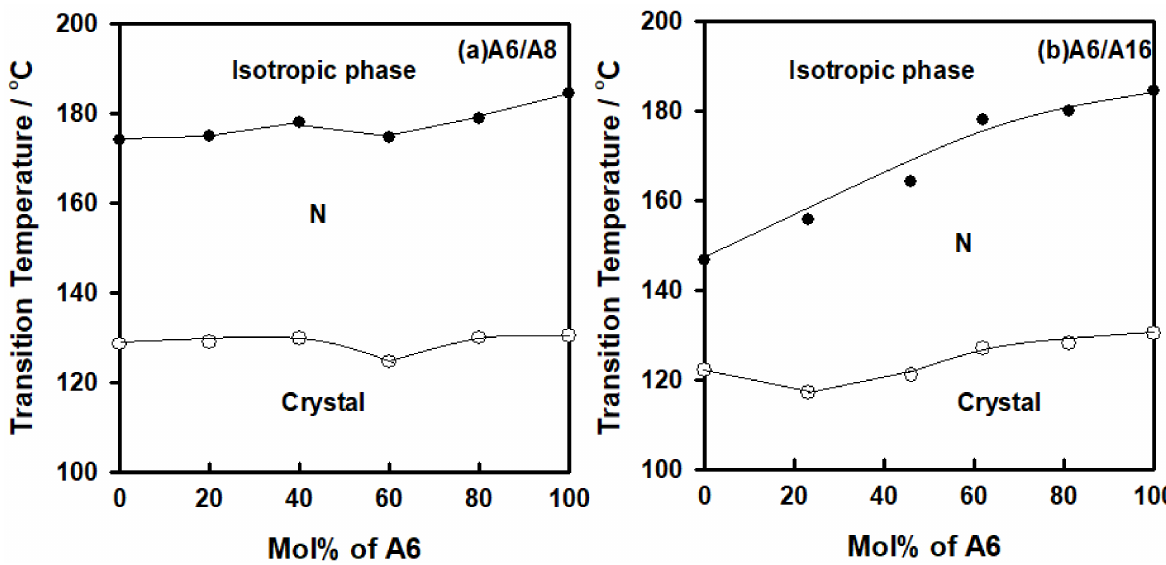
” denotes crystal–nematic transition, and “ • ” denotes (cid:35)